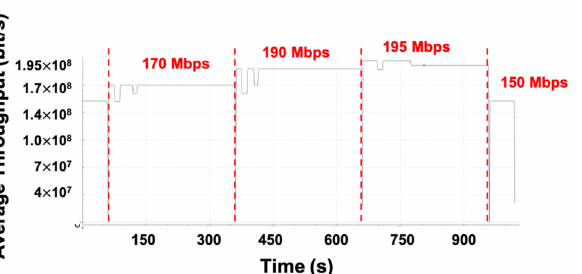
Figure 10. Real-time evolution of the allocated bandwidth for the residential user that contract the Premium Flexible Internet